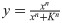
Probability of induction by a single large burst and quasi-steady state.(A)Two typical single-cell time traces of permease levels. The first shows induction by a single full dissociation event of the repressor from the operon (left), while the second shows a failure to induce (right). (B) The large burst size in the presence of positive feedback is remarkably prolonged compared with the case without positive feedback. (C) Successful probability of induction by a complete dissociation event as a function of the extracellular inducer concentration. (D-G) Probability of induction within different time windows starting from uninduced cells (blue) or induced cells (red); we determined the stochastic threshold through mathematical fitting in the form of y=xnxn+Kn for these curves. The deterministic threshold is approximately 20(molec.), while the stochastic thresholds are larger and decrease when the time window is extended. The extracellular inducer concentration, Ie, is set to 40μM.